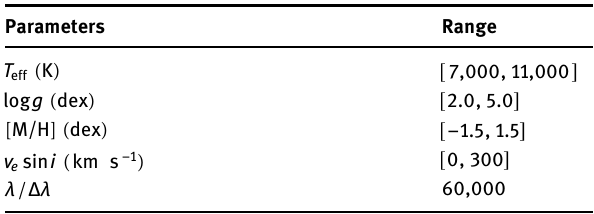
Table 1: Ranges of the parameters used for the calculation of the synthetic spectra